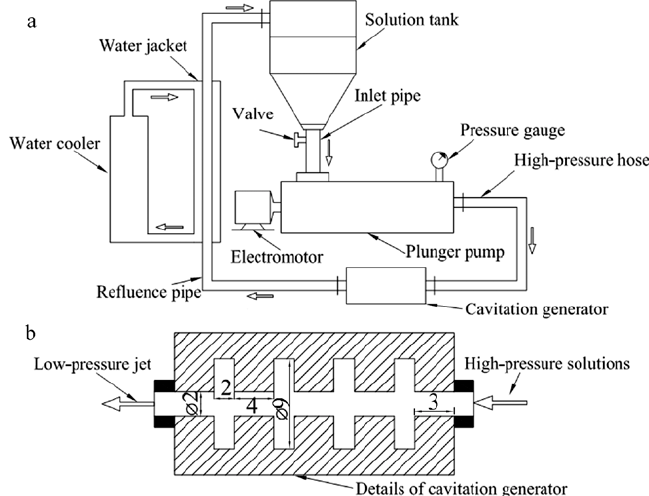
Figure 12. ( a ) Schematic of the designed jet cavitation device. ( b ) Details of the cavitation generator (mark unit: mm). Reproduced from [22]. Copyright IOP Publishing, 2011.